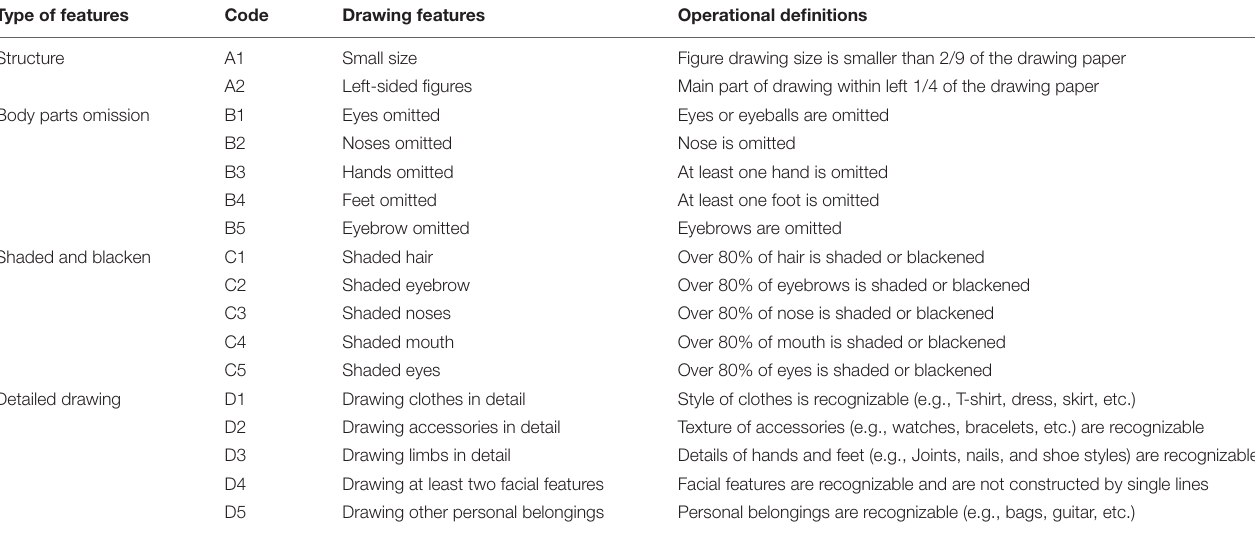
TABLE 1 | Operational definition of drawing features.